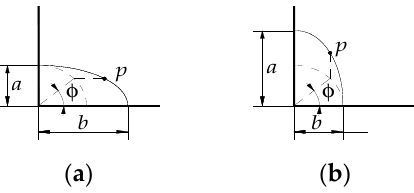
Figure 2. Angle φ defining a specific point p over the crack front: ( a ) a / b ≤ 1; ( b ) a / b > 1.